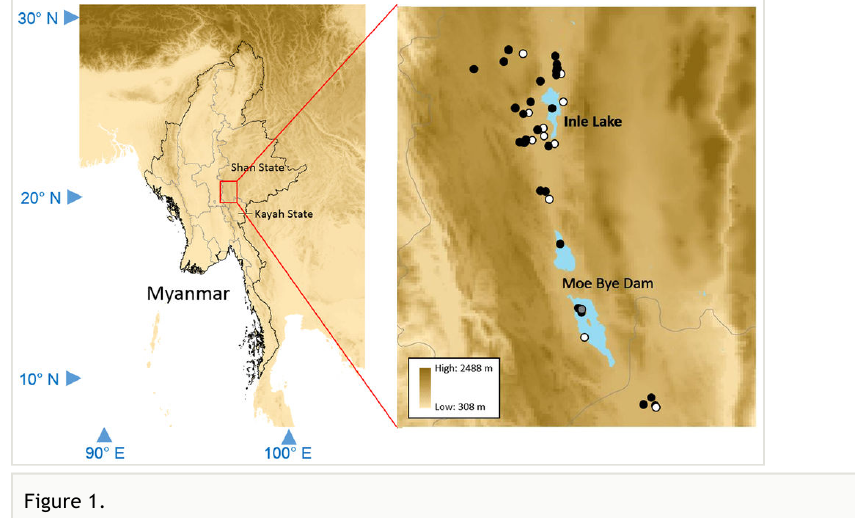
Figure 1. Spatial coverage of the sampling points. Solid circles indicate wild environments such as rivers and reservoirs. White circles indicate local markets and a grey circle indicates a fi sh cage in the